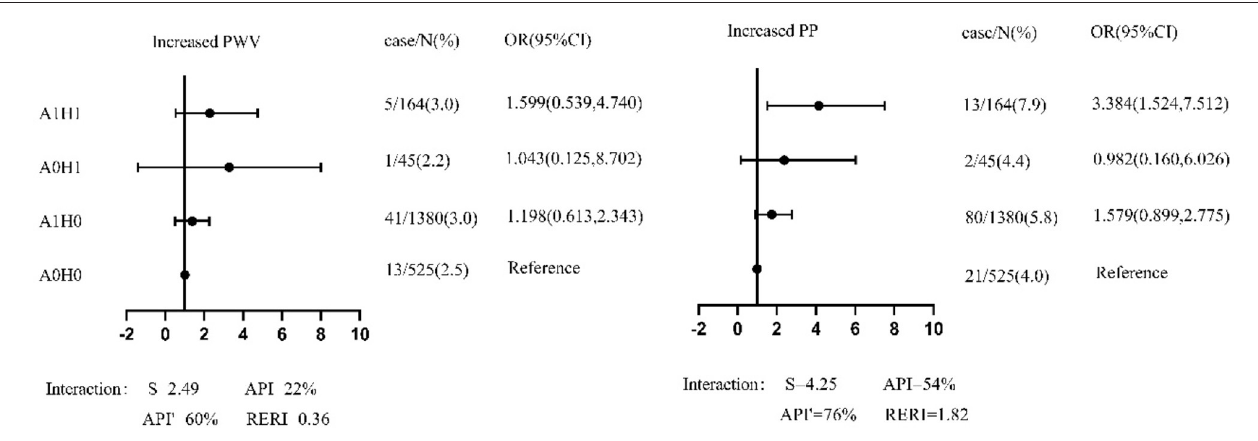
and PP [OR = 1.66 (0.98–2.82)} were not associated with increased baPWV/PP compared with the normal glomerular filtration or normal metabolism, respectively. Abnormal =